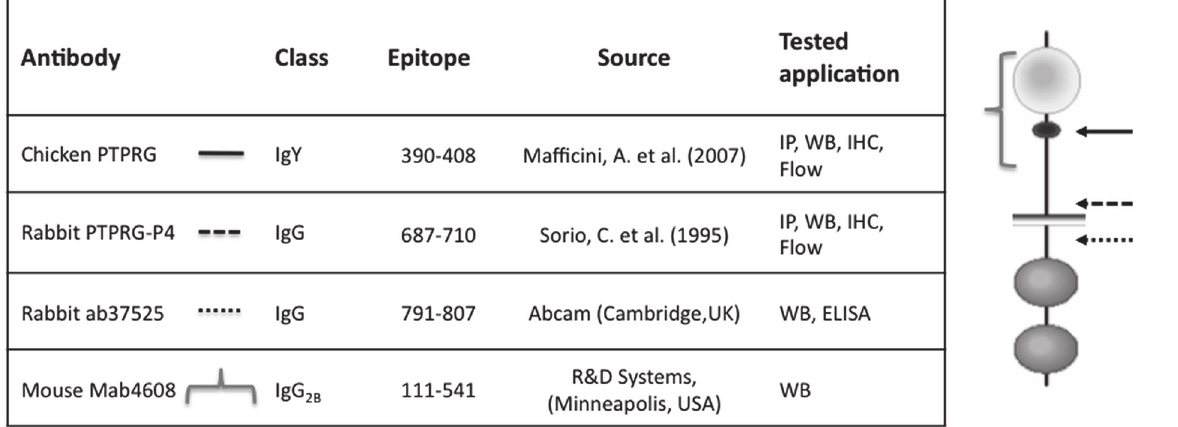
Fig 1. Schematic representation of antibodies used. Epitope: aminoacid number of epitope (NCBI protein accession number P23470), Tested application: IP = immunoprecipitation, WB = Western blot, IHC = immunohystochemistry, Flow = flow cytometry. Right image: approximate position of the epitopes recognized by selected antibody within the predicted protein